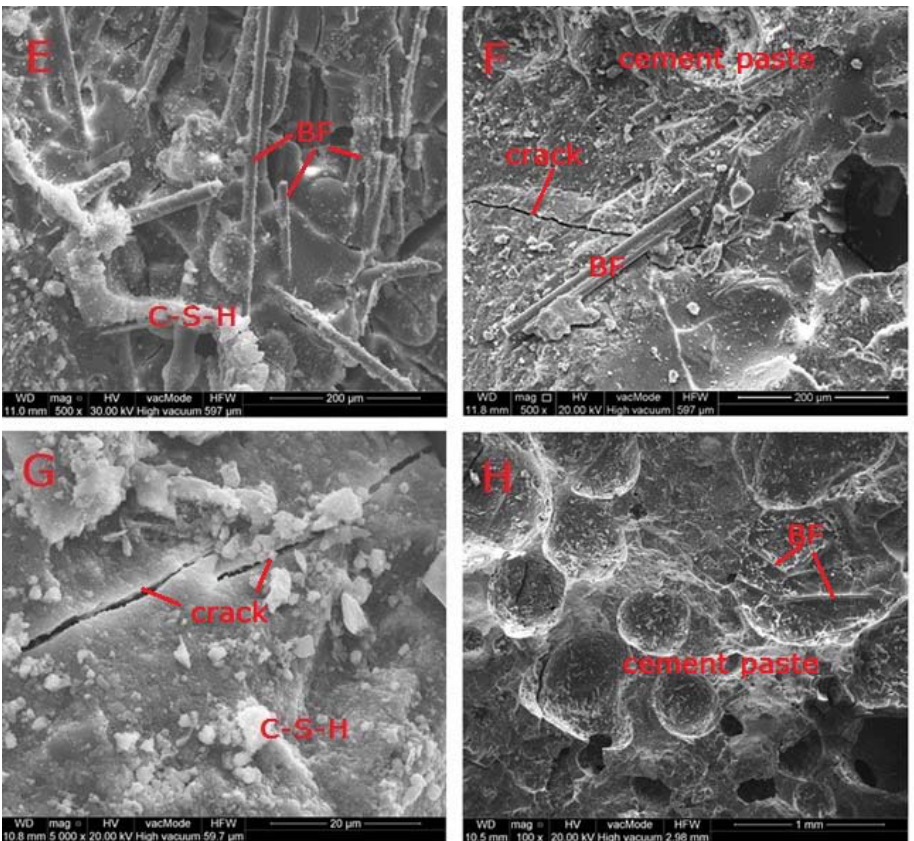
Figure 7. Microstructure of hybrid fibres-reinforced SCLC: ( A ) C15P0 (×1000); ( B ) C15P1b (×2000); ( C ) C5P1b (×5000); ( D ) C5P50b50s (×70); ( E ) C15P1b (×500); ( F ) C15P1b (×500); ( G ) C5P50b50s (×5000); ( H ) C15P1b (×100).